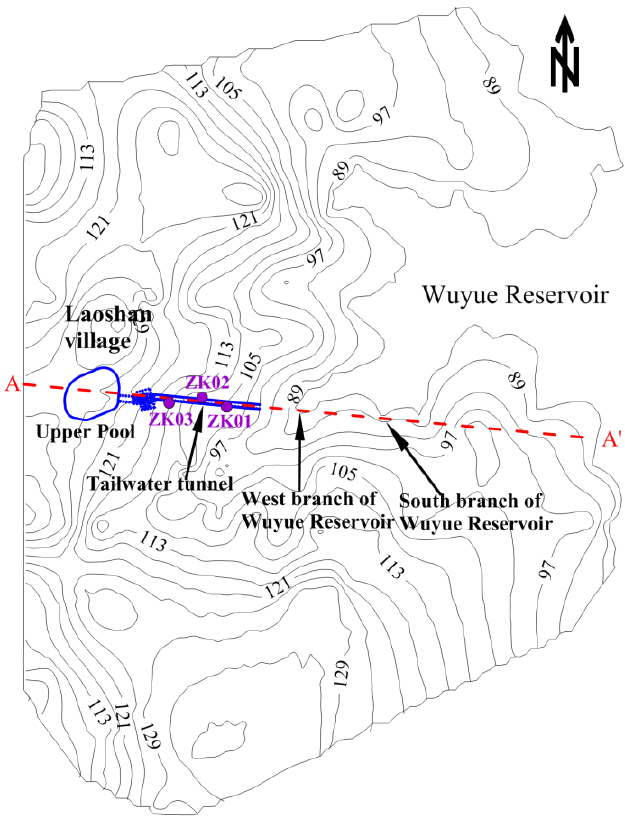
Figure 4. The scope of the hydrogeological survey and the water level isoline.